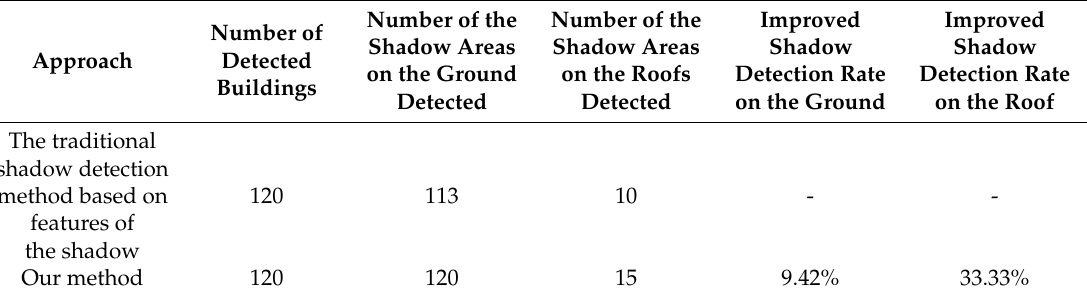
Table 2. Comparison of the two methods.